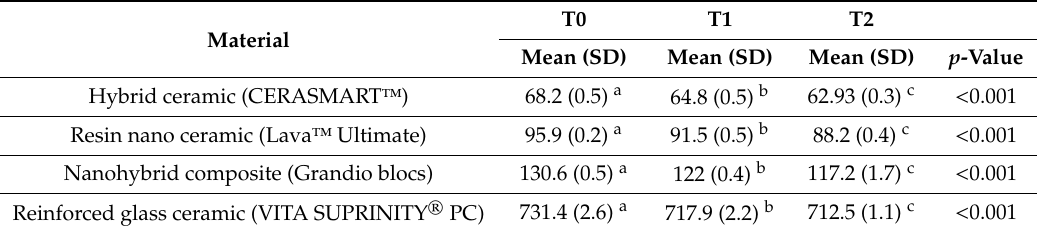
Table 2. Micro-hardness values between di ff erent immersion protocols. (T0: baseline; T1: immersion for 7 days; T2: immersion for 28